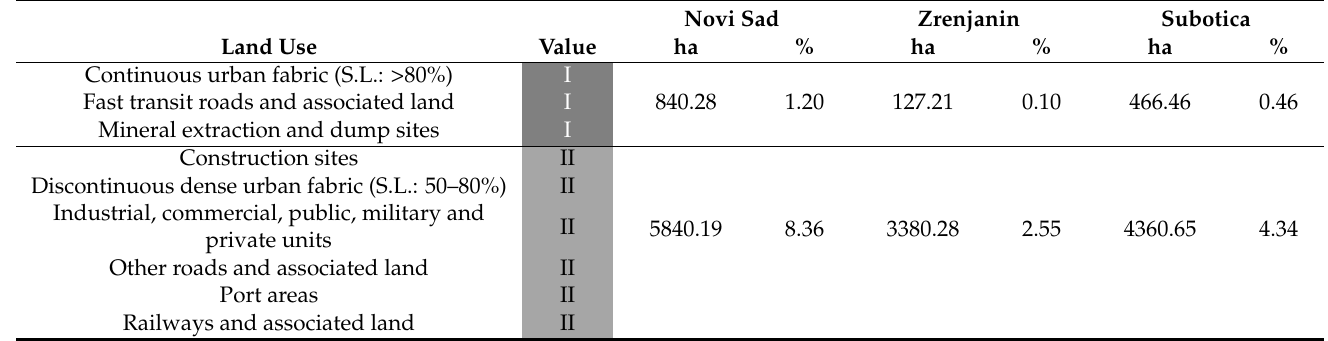
Table 2. The classification of landscape element classes according to the Grey-Green Continuum concept. Novi Sad Zrenjanin Subotica Land Use Value ha % ha %